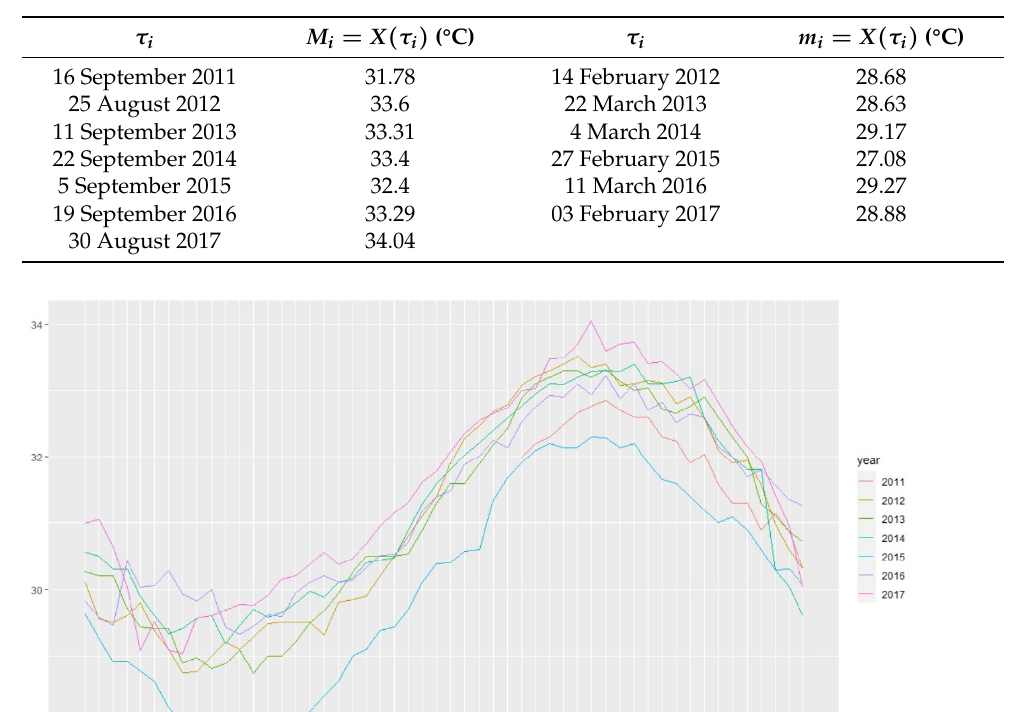
Table 1. Local maxima M i and minima m i for each subset of the dataset and the corresponding dates τ i (day, month, and year).